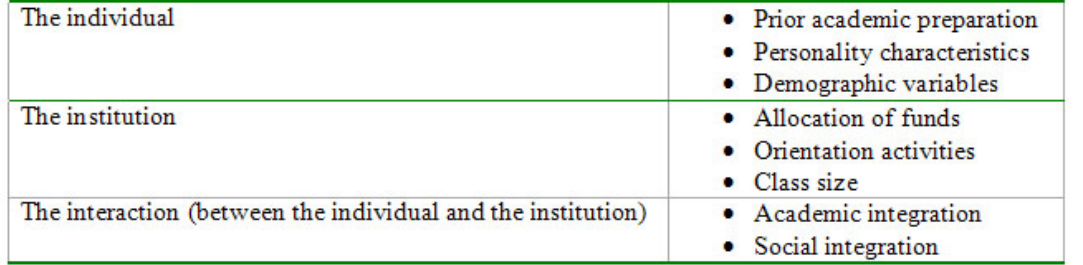
Dropout rates are of concern because, as reported in Berge and Huang (2004) and referencing Tinto’s (1982) work, “Historically, the percentage of students who dropout of brick and mortar higher education has held constant at between 40 – 45% for the past 100 years” (¶